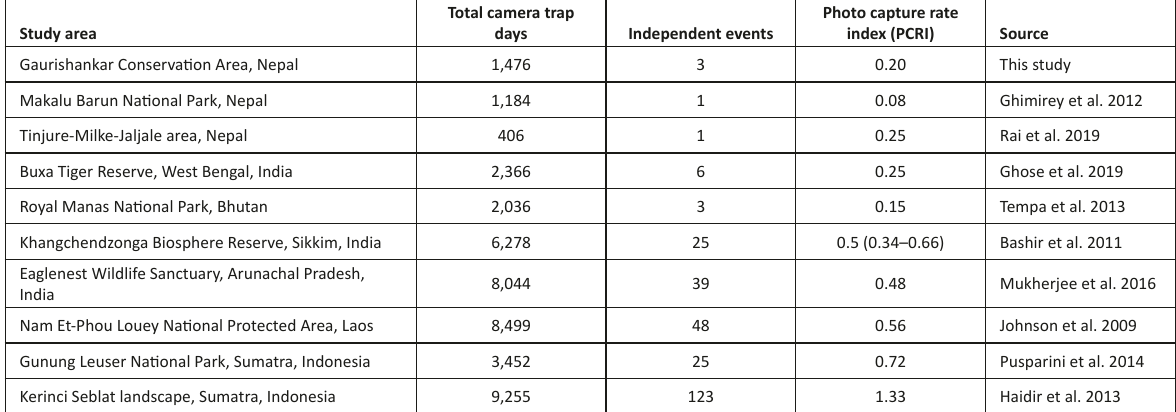
Table 2. Photocapture rates of Asiatic Golden Cat in selected survey areas in